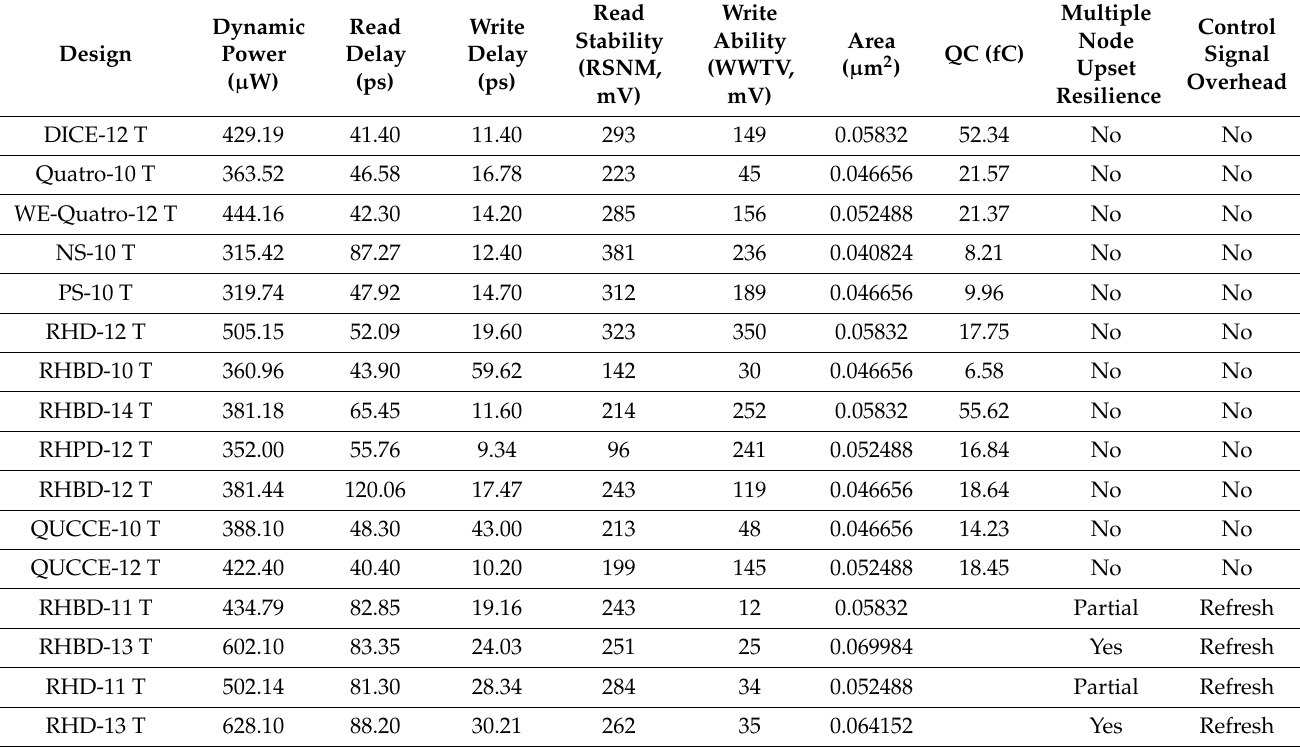
Table 1. Comparison of various radiation-hardening SRAM cell